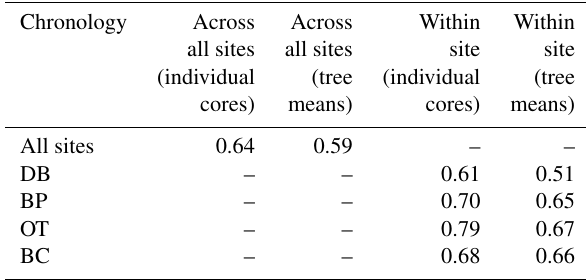
Table 3. Descriptive statistics of site-level and combined tree ring chronologies generated using COFECHA.